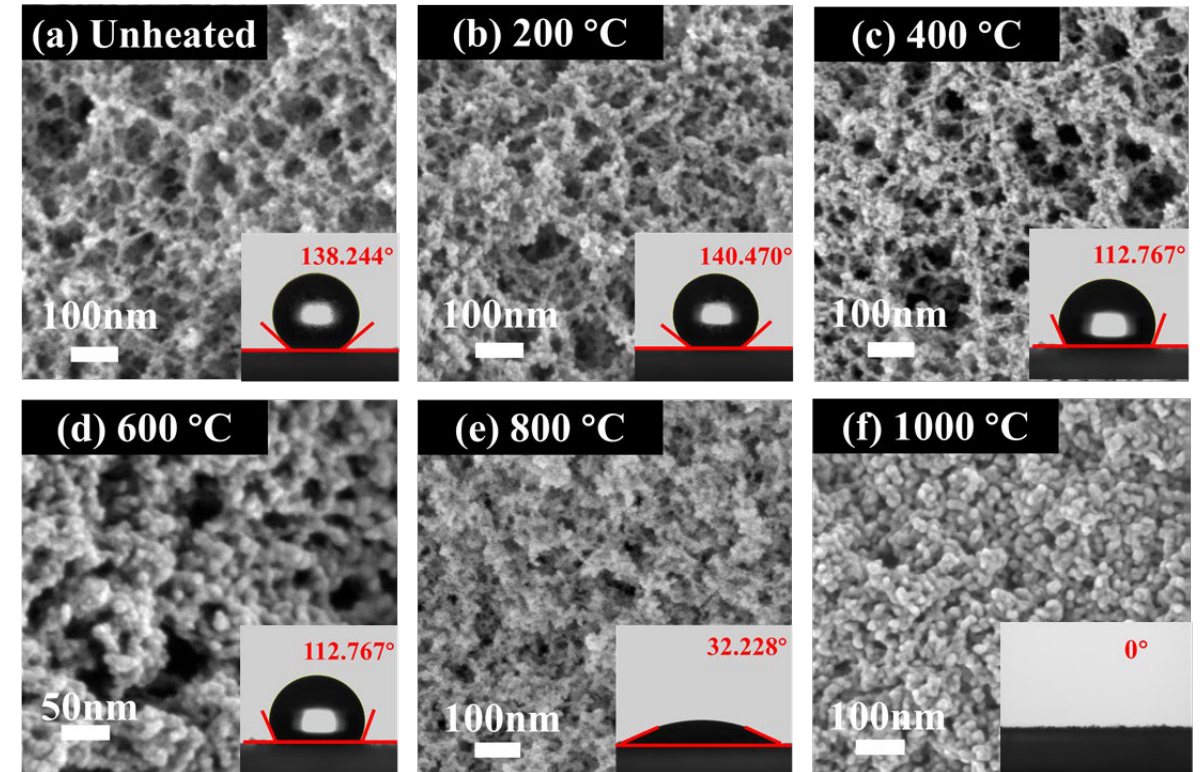
Figure 2. SEM images of silica aerogel treated at different heat treatment temperatures ( a ) Unheated, ( b ) 200 °C, ( c ) 400 °C, ( d ) 600 °C, ( e ) 800 °C, ( f ) 1000 °C.